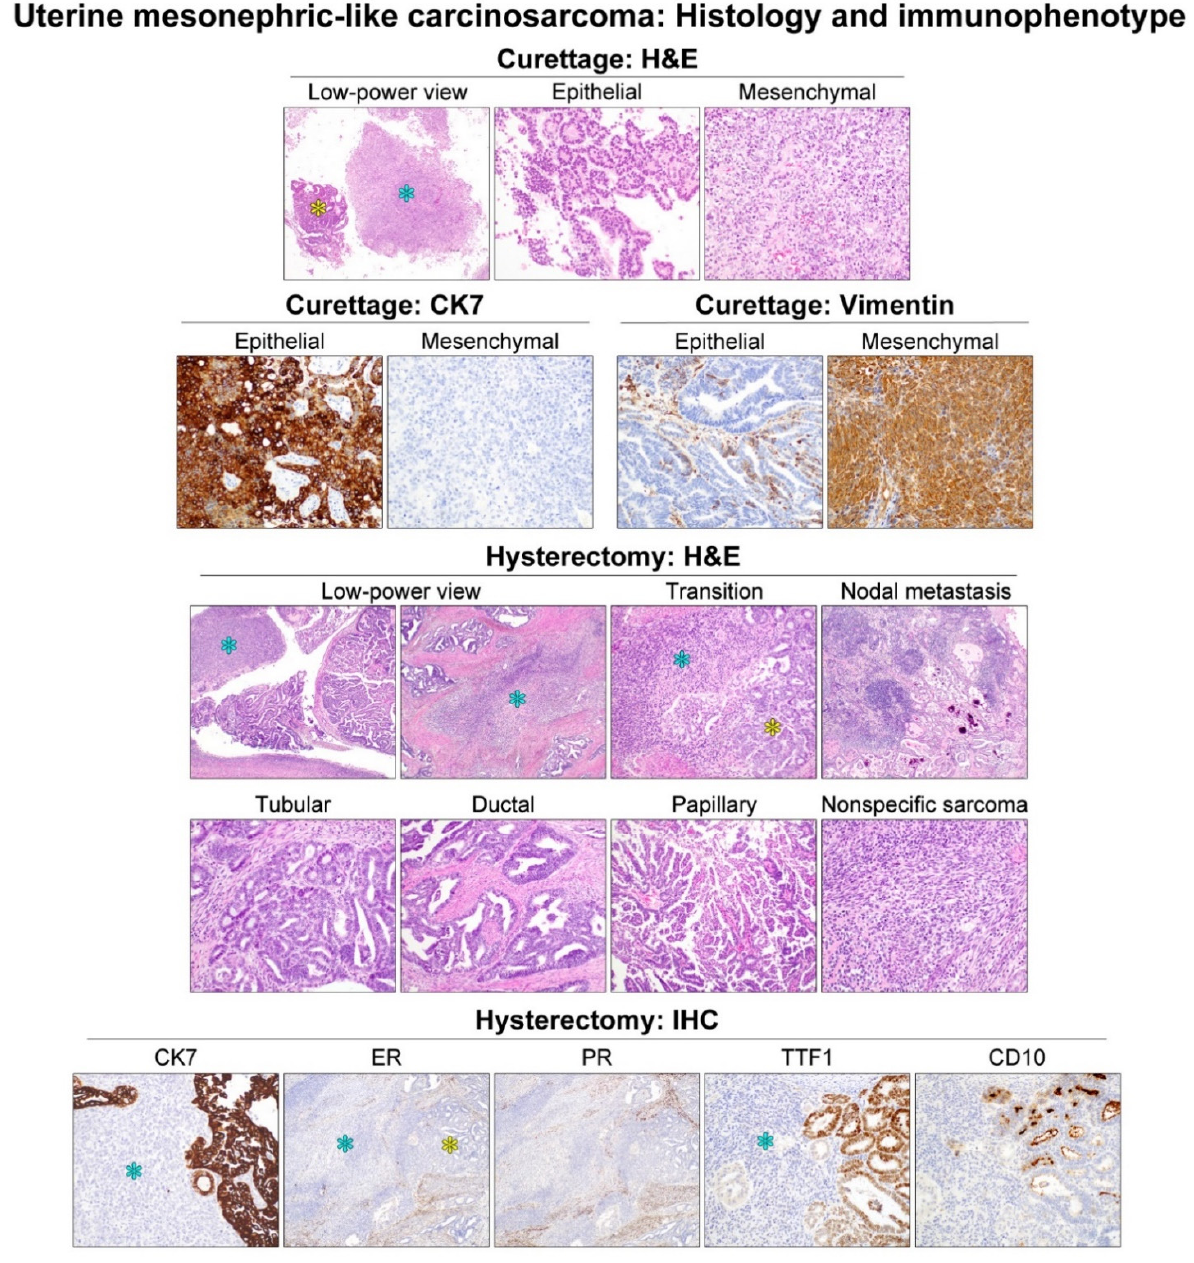
Figure 2. Histological features and immunophenotype of uterine MLCS: representative case (case 11). The endometrial curettage specimen revealed both the epithelial (yellow asterisk) and mesenchymal (blue asterisk) components, compatible with the diagnosis of carcinosarcoma. Immunostaining results further supported the diagnosis because the epithelial component was positive for cytokeratin 7 (CK7) but negative for vimentin, and the opposite in the mesenchymal component. The hysterectomy specimen also revealed two histological components. Several microscopic foci showing a transition between the two components were noted. The epithelial component showed various growth patterns, including tubular, ductal, and papillary architecture, and a typical immunophenotype for MLA, including TTF1 and CD10 positivity accompanied with hormone receptor negativity. These findings were characteristic of uterine MLA. Nodal metastatic tumor consisted exclusively of MLA. The mesenchymal component, morphologically high-grade nonspecific sarcoma, did not react with any hormone receptor or mesonephric marker.